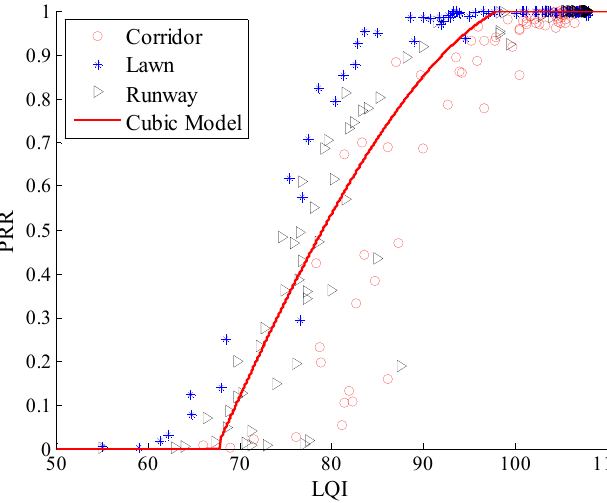
Figure 22. E ff ects of the cubic model in di ff erent Figure 22. Effects of the cubic model in different environments.